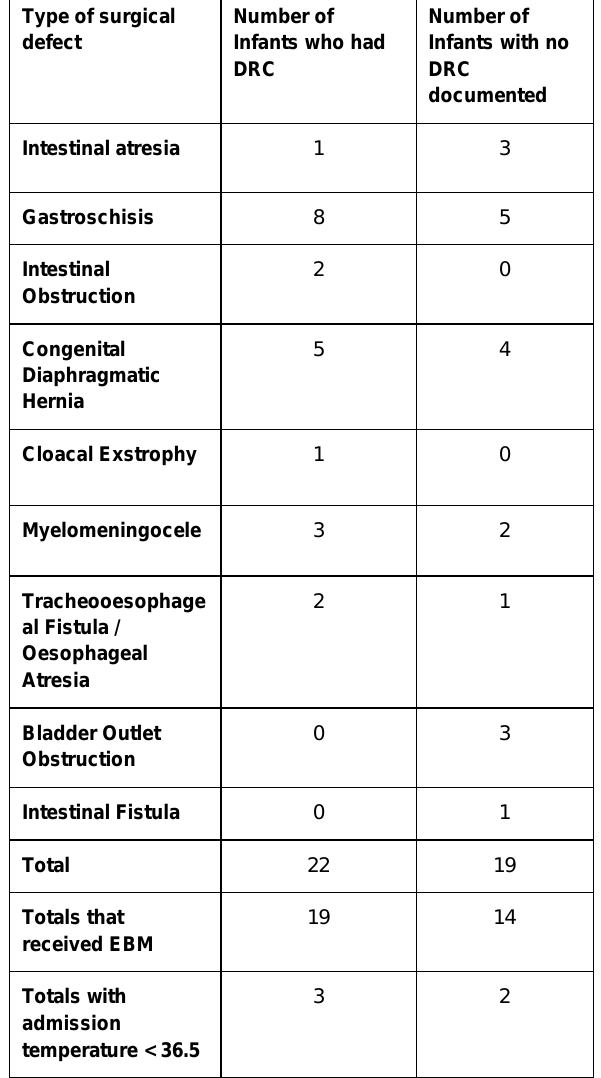
Table 1: Diagnoses for all inborn infants with antenatally diagnosed surgical defects at St. Mary’s Hospital, Mancheste r, between October 2020 and May 2021, with rates of DRC and hypothermia on admission Type of